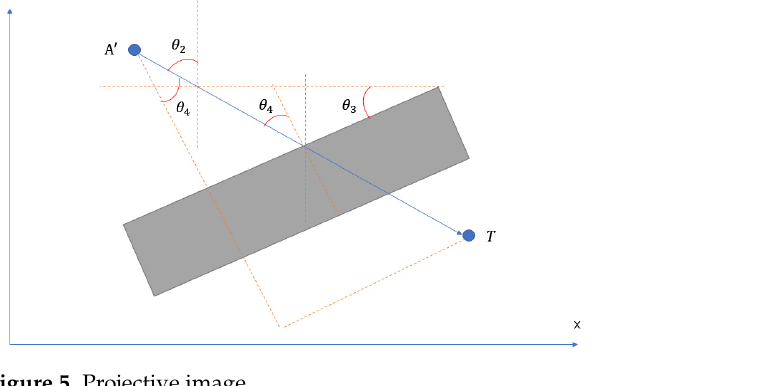
Figure 5. Projective image.